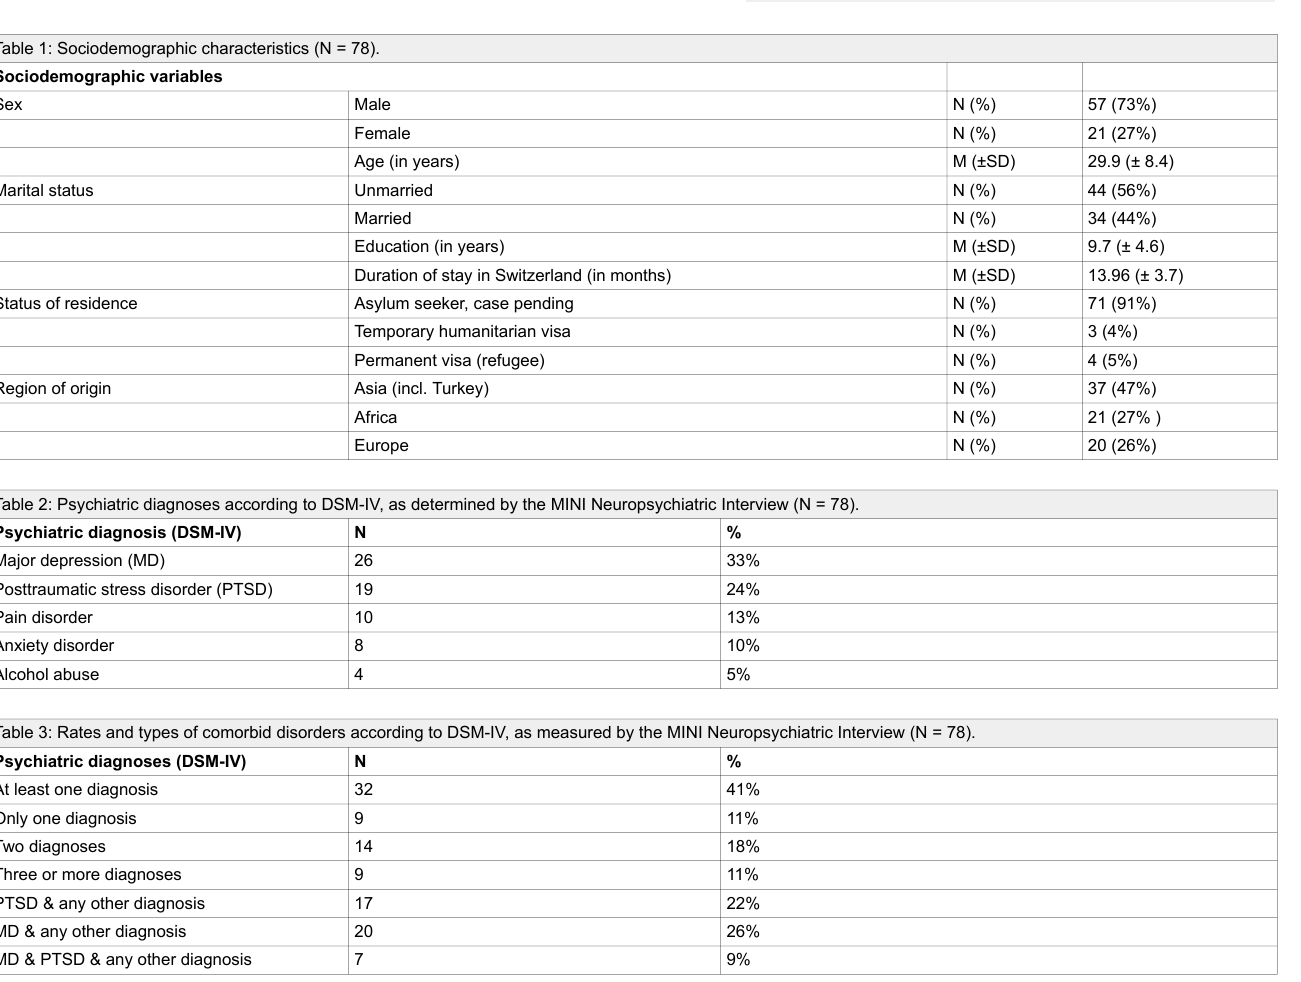
Distribution of annual healthcare costs by individual. N = 78.